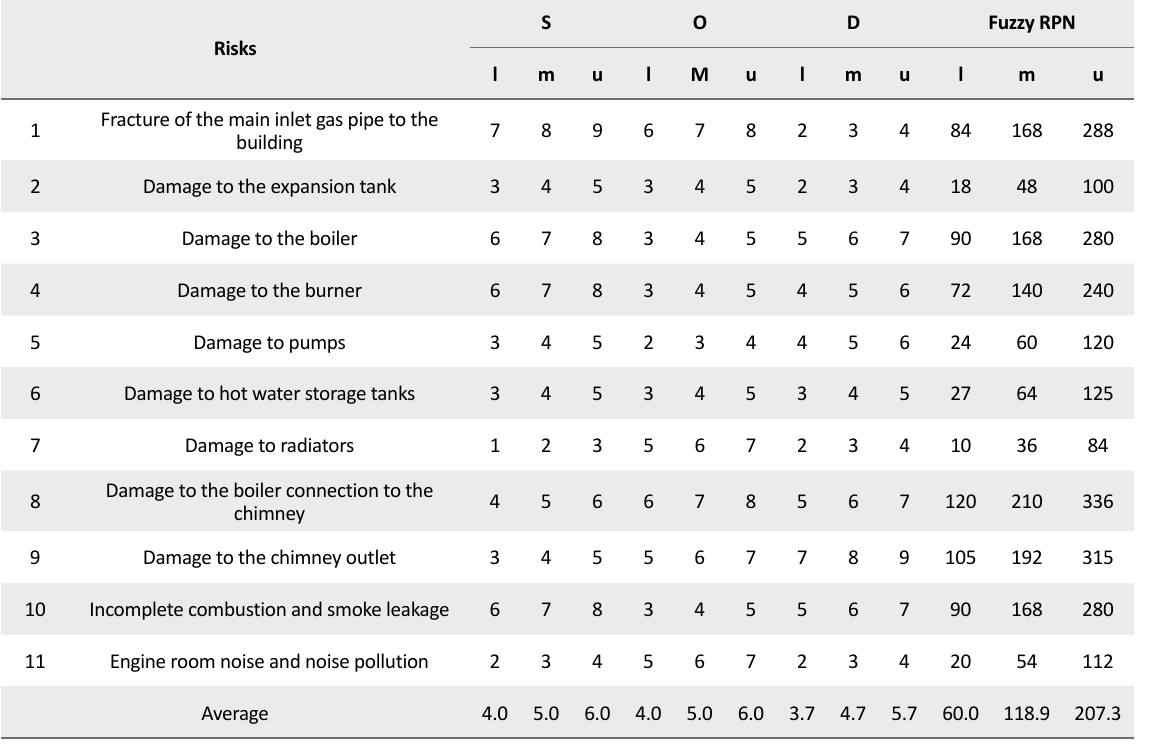
Table 6. Estimated mean scores related to the risks of CHBR in the fuzzy